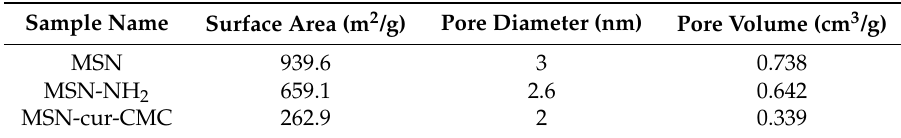
Table 2. Nitrogen adsorption-desorption analysis of MSNs.